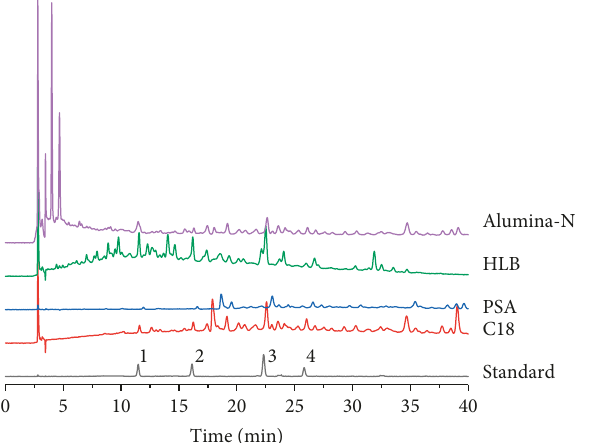
Figure 4: Comparison of HPLC chromatograms obtained using different SPE methods for analysis four phenylethanoid glycosides in LDC. (1) Purpureaside C, (2) jionoside A1, (3) acteoside, and (4) isoacteoside. Table 1: Recoveries of the four phenylethanoid glycosides and five triterpene acids from spiked samples using different SPE cartridges.